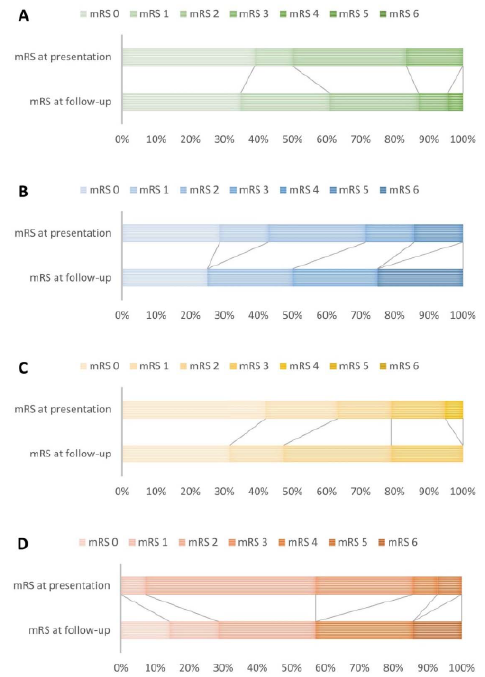
Figure 4. Distribution of the proportions of modified Rankin Scales (mRS) for: ( A ) surgically treated group with childhood-onset (missing n = 5 at presentation); ( B ) medically treated group with childhood-onset (missing n = 1 at presentation); ( C ) surgically treated group with adult-onset; ( D ) medically treated group with